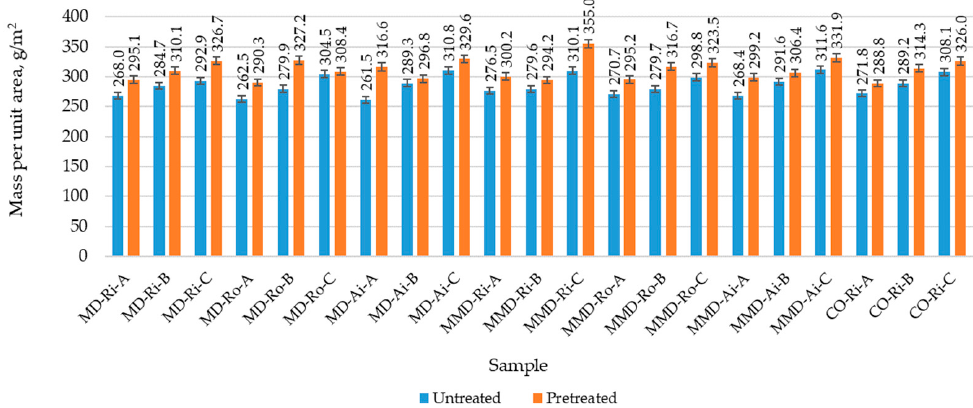
Figure 9. Mass per unit area of the untreated and pretreated sock plain knit samples determined before and after five repeated washing and drying cycles of the socks (where MD—modal fibers, MMD—micro modal fibers, CO—cotton fibers; Ri—ring spun yarn, Ro—rotor spun yarn, Ai—air-jet spun yarn; A, B, C—sock group).